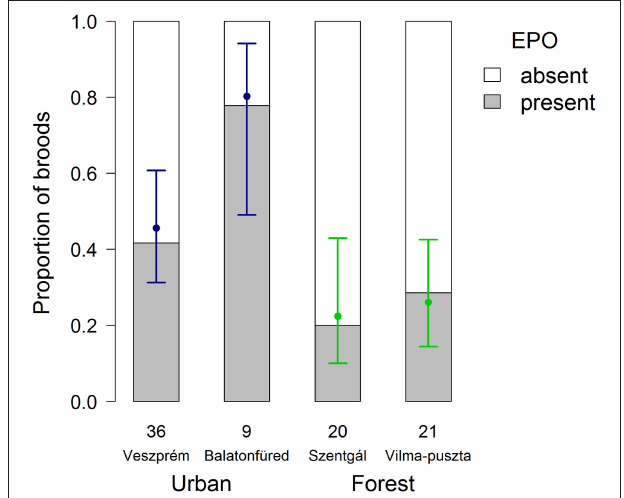
FIGURE 1 | Occurrence of extra-pair offspring (EPO) in great tit broods at urban and forest study sites. Numbers below the bars refer to the number of genotyped broods in each site. Dots and whiskers show means and 87% confidence intervals, respectively, both calculated from the GEE model with study sites and years as predictors. Non-overlapping 87% CIs indicate statistically significant difference (i.e., that a 95% CI of the difference excludes